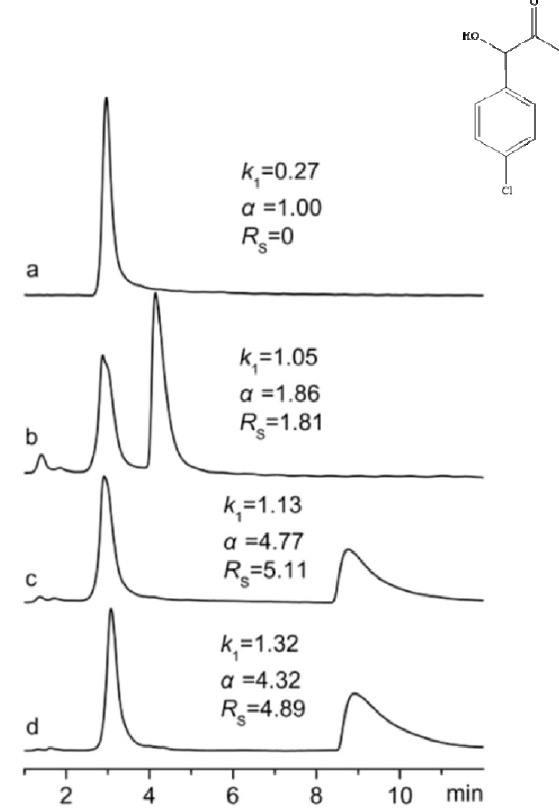
Figure 12. Effect of the mobile phase composition on enantioseparation of 4-chloromandelic acid resolved by CSP 1. Mobile phase: (a) ACN/(water/TFA) (60/40, v/v ); (b) ACN/(water/TFA) (70/30, v/v ); (c) ACN/(water/TFA) (80/20, v/v ); (d) ACN/(water/TFA)(90/10, v/v ), flow-rate: 1.0-mL·min − 1 , UV: 254 nm [194]. Reprinted from Analytica Chimica Acta , ref. [194], Copyright (2020), with